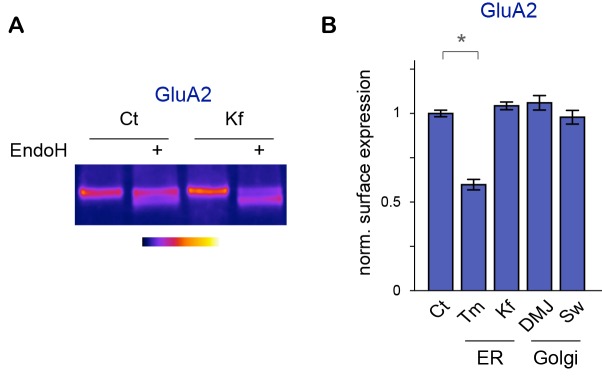
Core-glycosylation regulates GluA2 surface expression.Effects of ER (TM, Kf, DMJ) or Golgi (DMJ, Sw) N-glycosylation inhibitors (see Figure 5A) on the glycosylation profile and surface expression of GluA2. (A) GluA2 before or after digestion with EndoH in control neurons (Ct) and in neurons (DIV 24–27) exposed to Kf for two days, showing the effect of Kf on the glycosylation profile of surface proteins. Note the decreased intensity of the EndoH-insensitive (upper) band and the converse increased intensity of the EndoH-sensitive (lower) band. (B) Average surface levels of these proteins in neurons after a two-days-exposure to DMSO (control, Ct), tunicamycin (Tm, 1,2 μM), Kifunensine (Kf, 5 μM), 1-deoxymannojirimycin (DMJ, 75 μM) or swainsonine (Sw, 88 μM). Tm reduces the surface expression of GluA2. In contrast, Kf, DMJ and SW have no detectable effect on the surface expression of the protein. Mean ± SEM and individual data points; N=4–8 samples from 2–5 independent experiments. *p<0.05; Kruskal-Wallis/Dunn’s multiple comparison test.